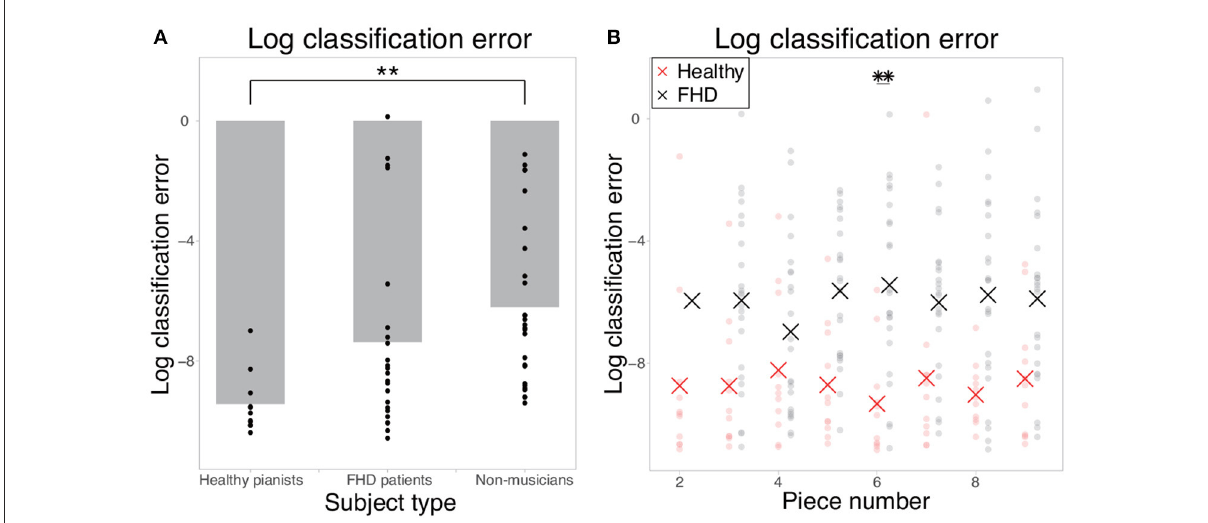
FIGURE2 Logarithmic classification errors in classifying finger joint data as that collected when individuals were playing at the fastest tempo or a natural tempo. (A) The logarithmic classification error in piece #1. Each dot indicates the error in each subject, and the gray bar indicates the mean classification error in each group. Double asterisks indicate significant differences with p < 0.01. (B) The logarithmic classification error in the cases of pieces #2-#9. Each red and black dot indicates the error in each healthy pianist and patient with FHD, respectively. Red and black asterisks indicate the mean logarithmic classification error in each piece. Double asterisks indicate significant differences with p < 0.01.